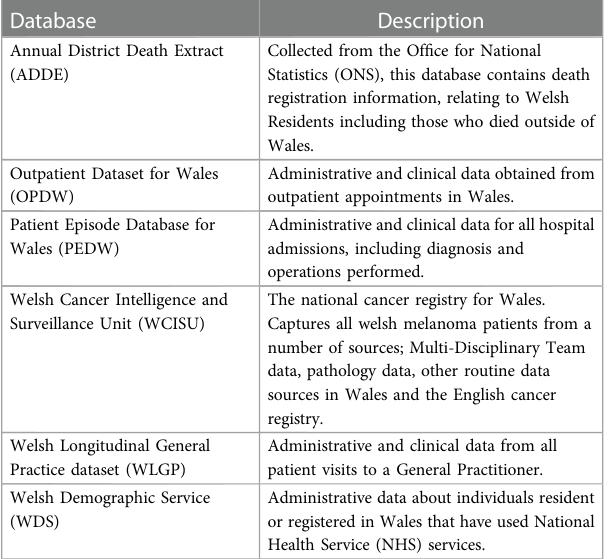
TABLE 1 List of databases used for data linkage and their